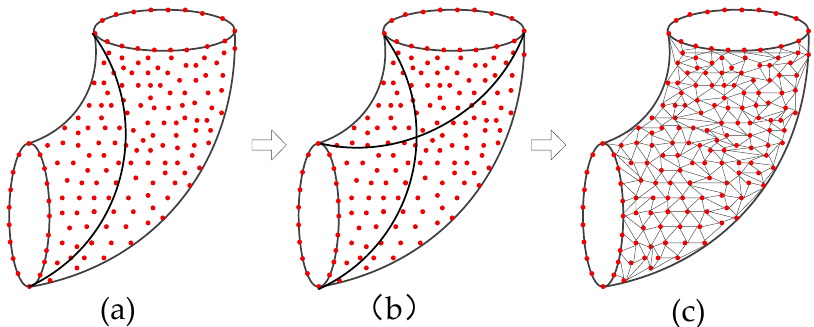
Figure 8. Bowyer – Waston triangulation : (a) generate a super triangle; (b) generate an initial Figure 8. Bowyer–Waston triangulation: ( a ) generate a super triangle; ( b ) generate an initial grid; ( c ) generate Delaunay grid; (c) generate Delaunay meshes.